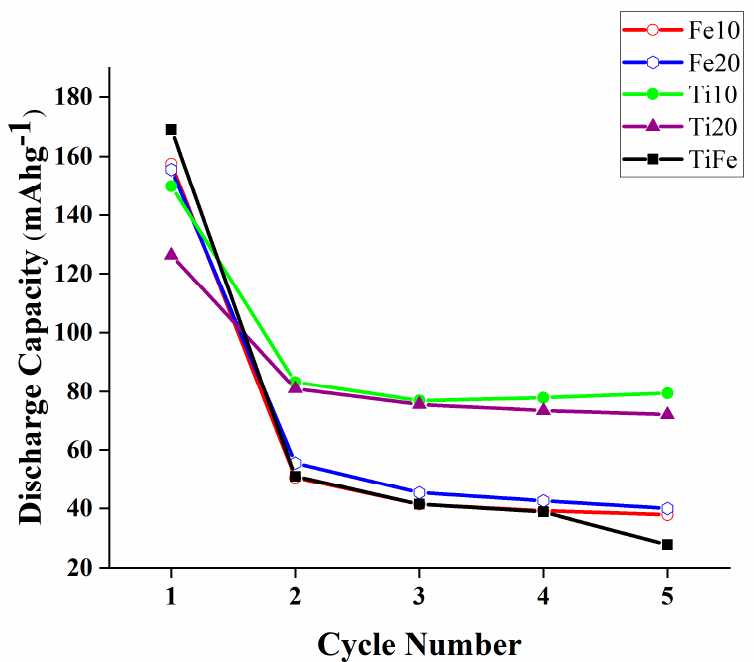
Figure 12. Discharge capacity of TiFe, Fe10, Fe20, Ti10, and Ti20 milled products after 60 h of milling as a function of cycle numbers.